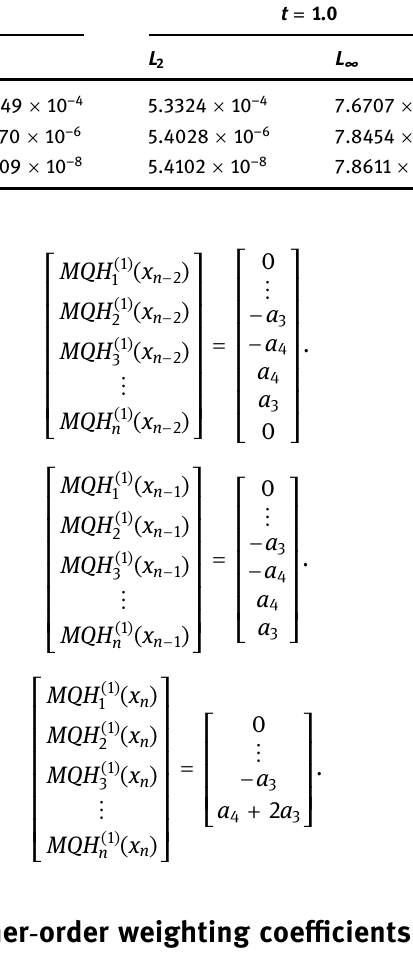
Table 2: L 2 and L ∞ at = t 0.1, 0.5 , and 1.0 = t 0.1 = t 0.5 = t